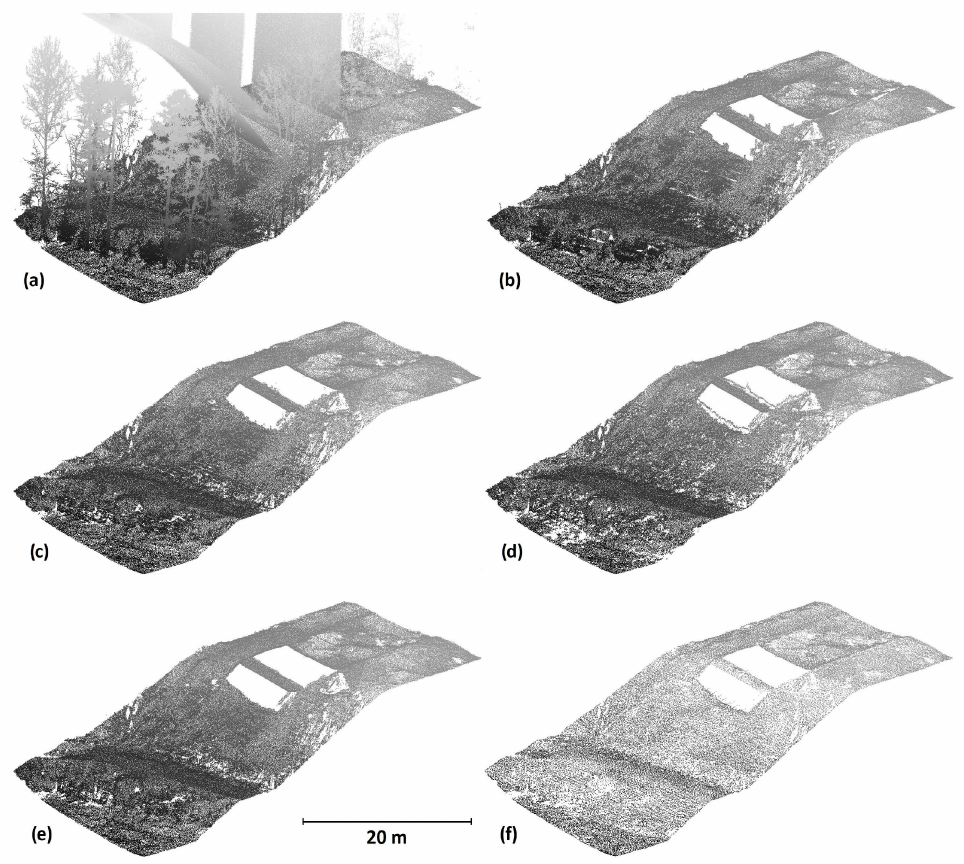
Figure A5. Results of filtering of site 4: ( a ) original data, ( b ) after PMF filtering, ( c ) after SMRF filtering, ( d ) after CSF filtering, ( e ) after ATIN filtering, and ( f ) after MDSR